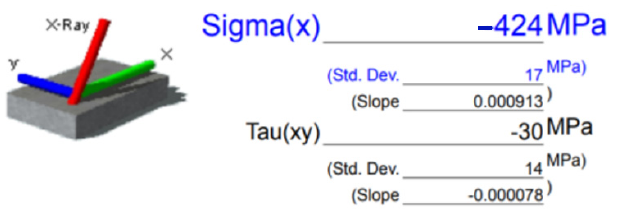
Figure 10. Residual stresses measurement for a laser power of 500 W.